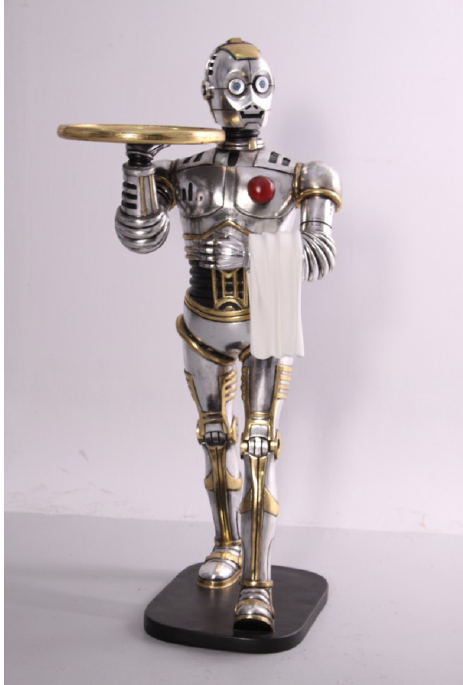
Figure 5. Figure that shows the main idea of what a future waiter robot could be. The possibilities of a humanoid robot are numerous. The ability to socialise with humans and their environments make this robot very useful. They push the boundaries